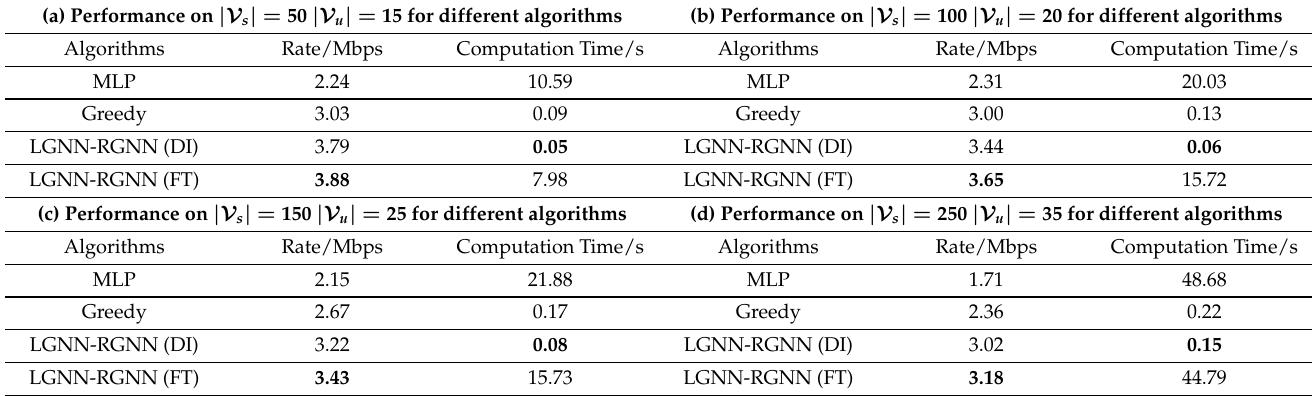
Table 2. Performance on a large-scale network for different